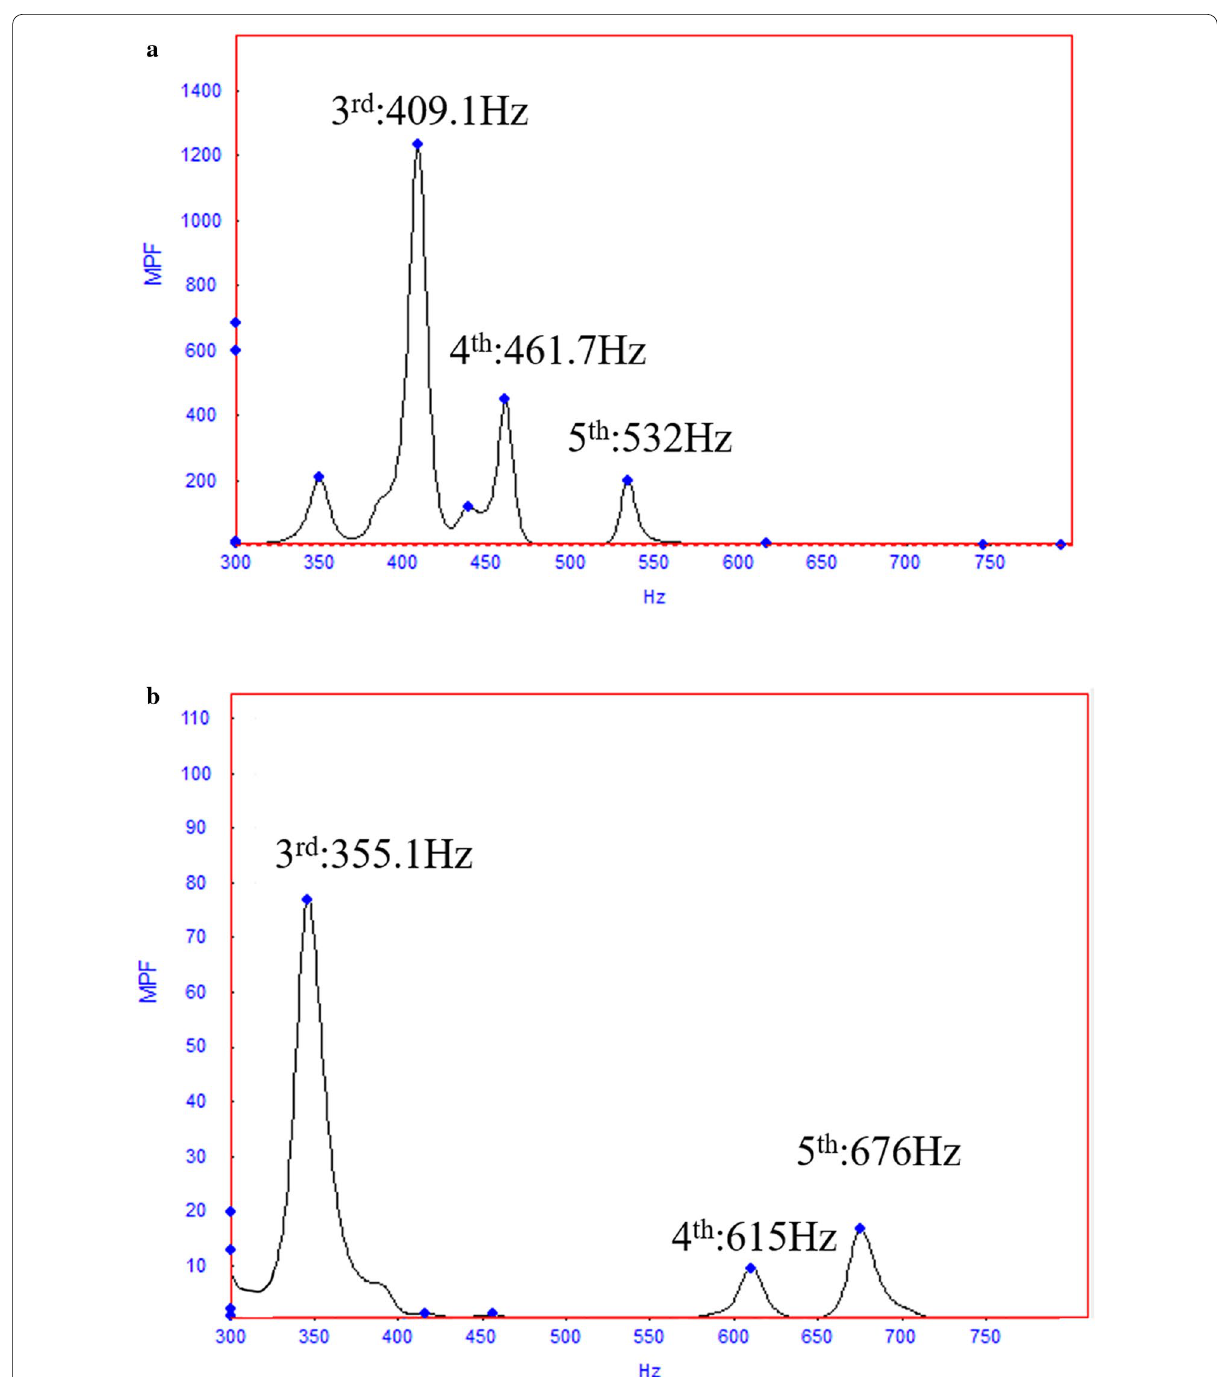
Figure 14 Mode participation before and after optimization. a Initial position. b Optimal